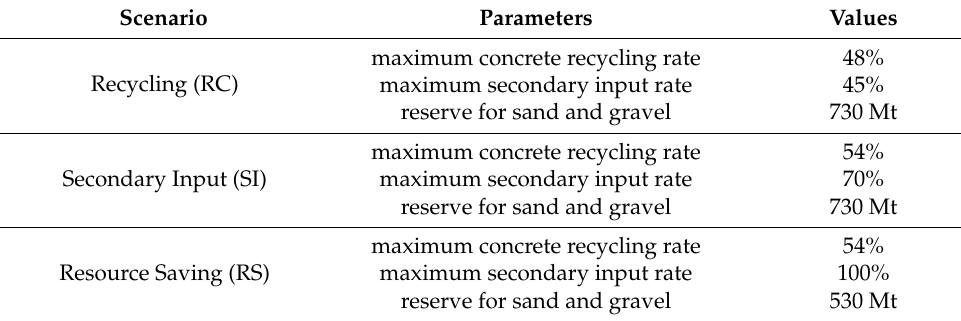
Table 2. Overview of the three scenarios and related